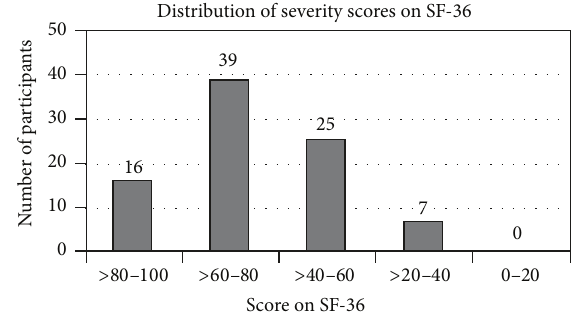
Figure 3: The number of participants that scored within each severity group on the SF-36. Lower scores indicate worse quality of life.